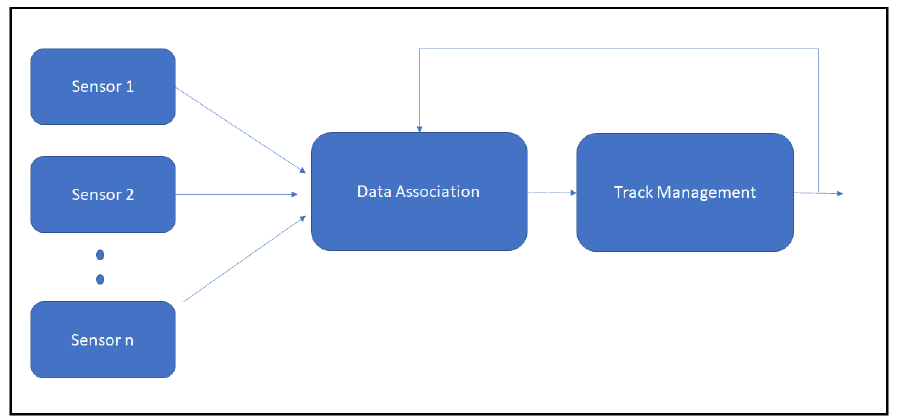
Figure 1. Target-level fusion architecture [5,7].